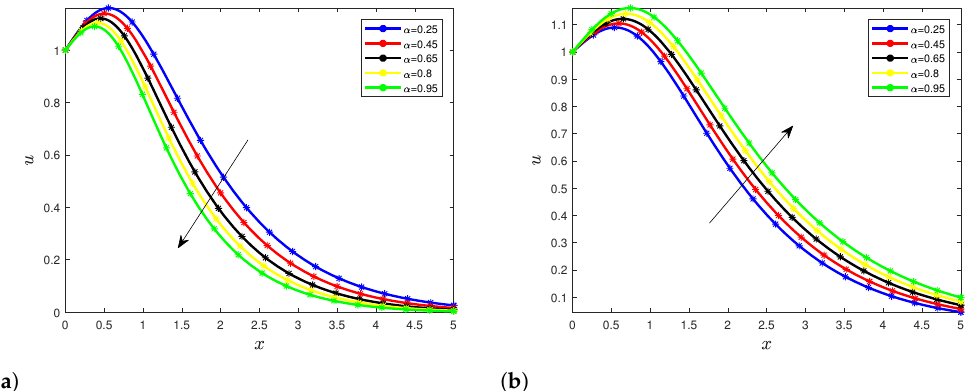
Figure 6. Dynamics of the fractional diffusion reaction equation with various orders with, respectively, τ = 0.5 ( a ) and τ = 1.5 ( b ) with β =